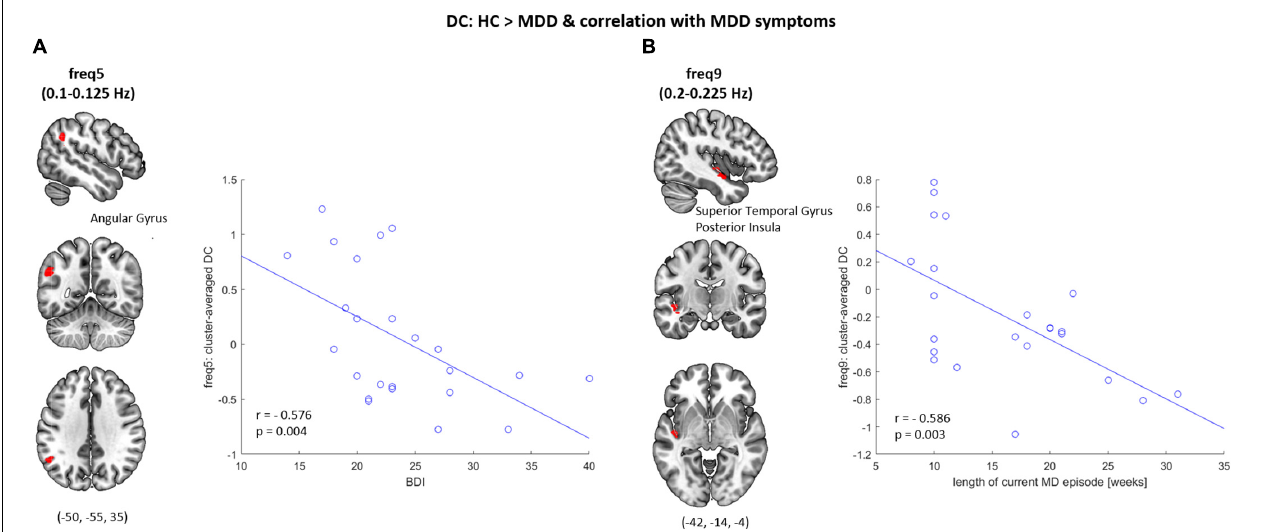
FIGURE 3 | Correlation between the DC and symptom severity. (A) At frequency band 5 (freq5: 0.1–0.125 Hz), decreased DC of the left angular gyrus was observed in MDD patients when compared to healthy controls (HC), which significantly correlated with the BDI scores ( r = − 0.576, p = 0.004). (B) At frequency band 9 (freq9: 0.2–0.225 Hz), decreased DC of the left superior temporal gyrus & posterior insula was observed in MDD patients when compared to HC, which significantly correlated with the length of current major depressive (MD) episode ( r = − 0.586, p =